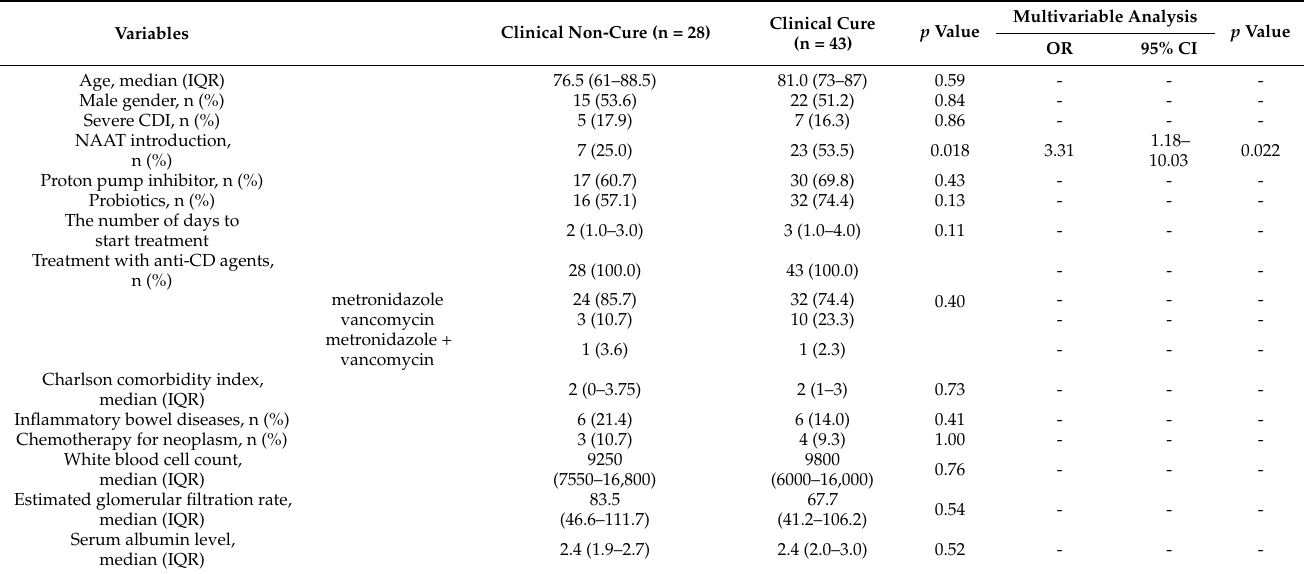
Table 3. Factors associated with clinical cure (univariable and multivariable